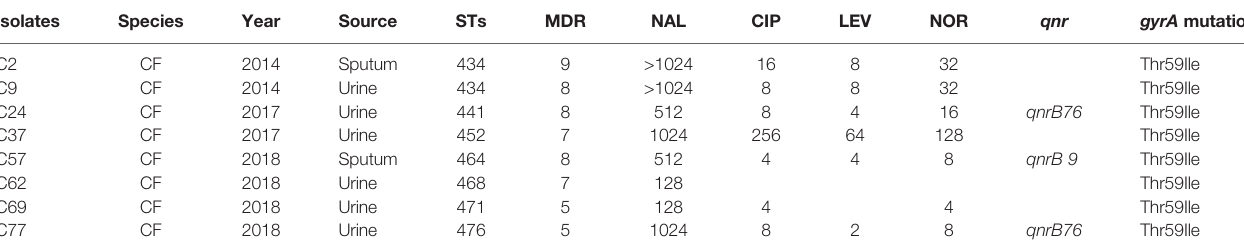
TABLE 4 | Fluoroquinolone resistant values and alterations detected in the gyrA genes of Citrobacter isolates. Isolates